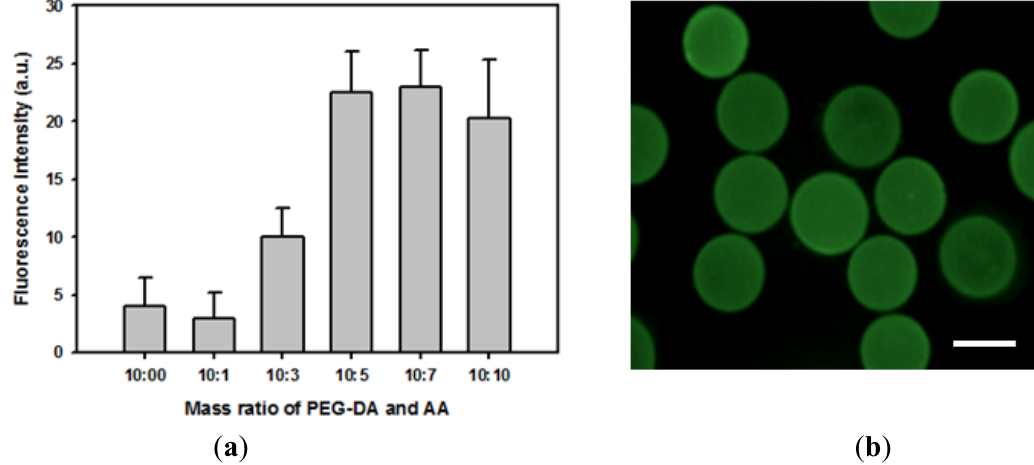
Figure 2. Immobilization of FITC-BSA onto hydrogel microparticles. ( a ) Effect of acrylic acid contents on the relative amount of FITC-BSA immobilized onto hydrogel microparticles. ( b ) Fluorescence image of hydrogel microparticles that were incubated with FITC-BSA (weight ratio of PEG-DA and acrylic acid was fixed to 2:1) (scale bar: 200 μ m).